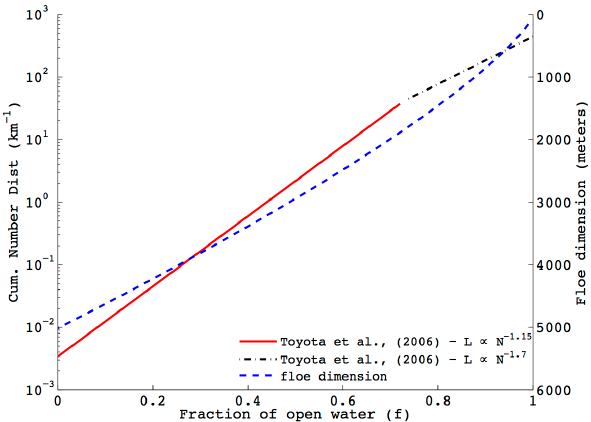
1 Figure 2. The relationship between the floe number distribution (N) per km 2 (left axis) and the 2 Fig. 2. The relationship between the floe number distribution ( N ) individual floe dimension, L (right axis), vs. the fraction (f) of open water area (or converse of 3 per km 2 (left axis) and the individual floe dimension, L (right axis), the SIC) from Toyota et al., (2006). N follows a distinct power law distribution when floe size 4 vs. the fraction ( f ) of open water area (or converse of the SIC) from decreases below a threshold (Toyota et al., 2006). 5 Toyota et al. (2006). N follows a distinct power law distribution when floe size decreases below a threshold (Toyota et al.,